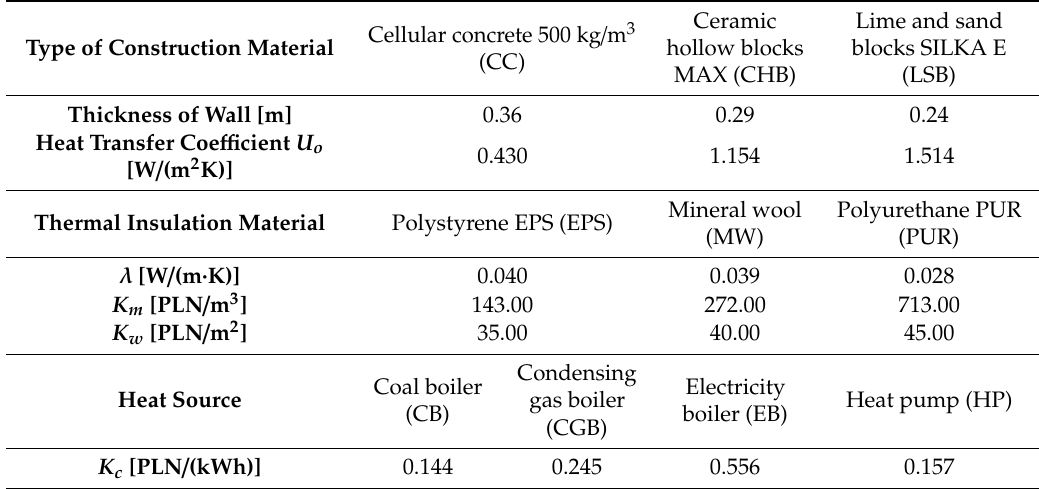
Table 1. Data for construction materials of walls, thermal insulation materials and heat sources.